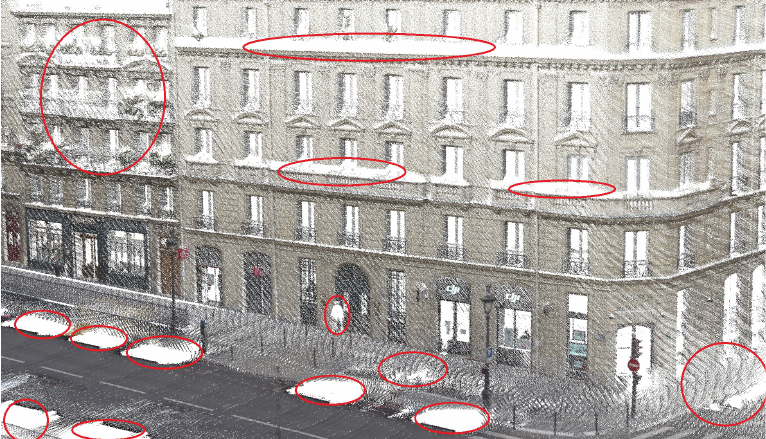
Figure 10. Paris data after removal of vehicles and pedestrians. Zones in red circles show the interest in conducting scene completion for 3D mapping, in order to fill holes from removed pedestrians, parked cars, and from the occlusion of other objects, and also to improve the sampling of points in areas far from the